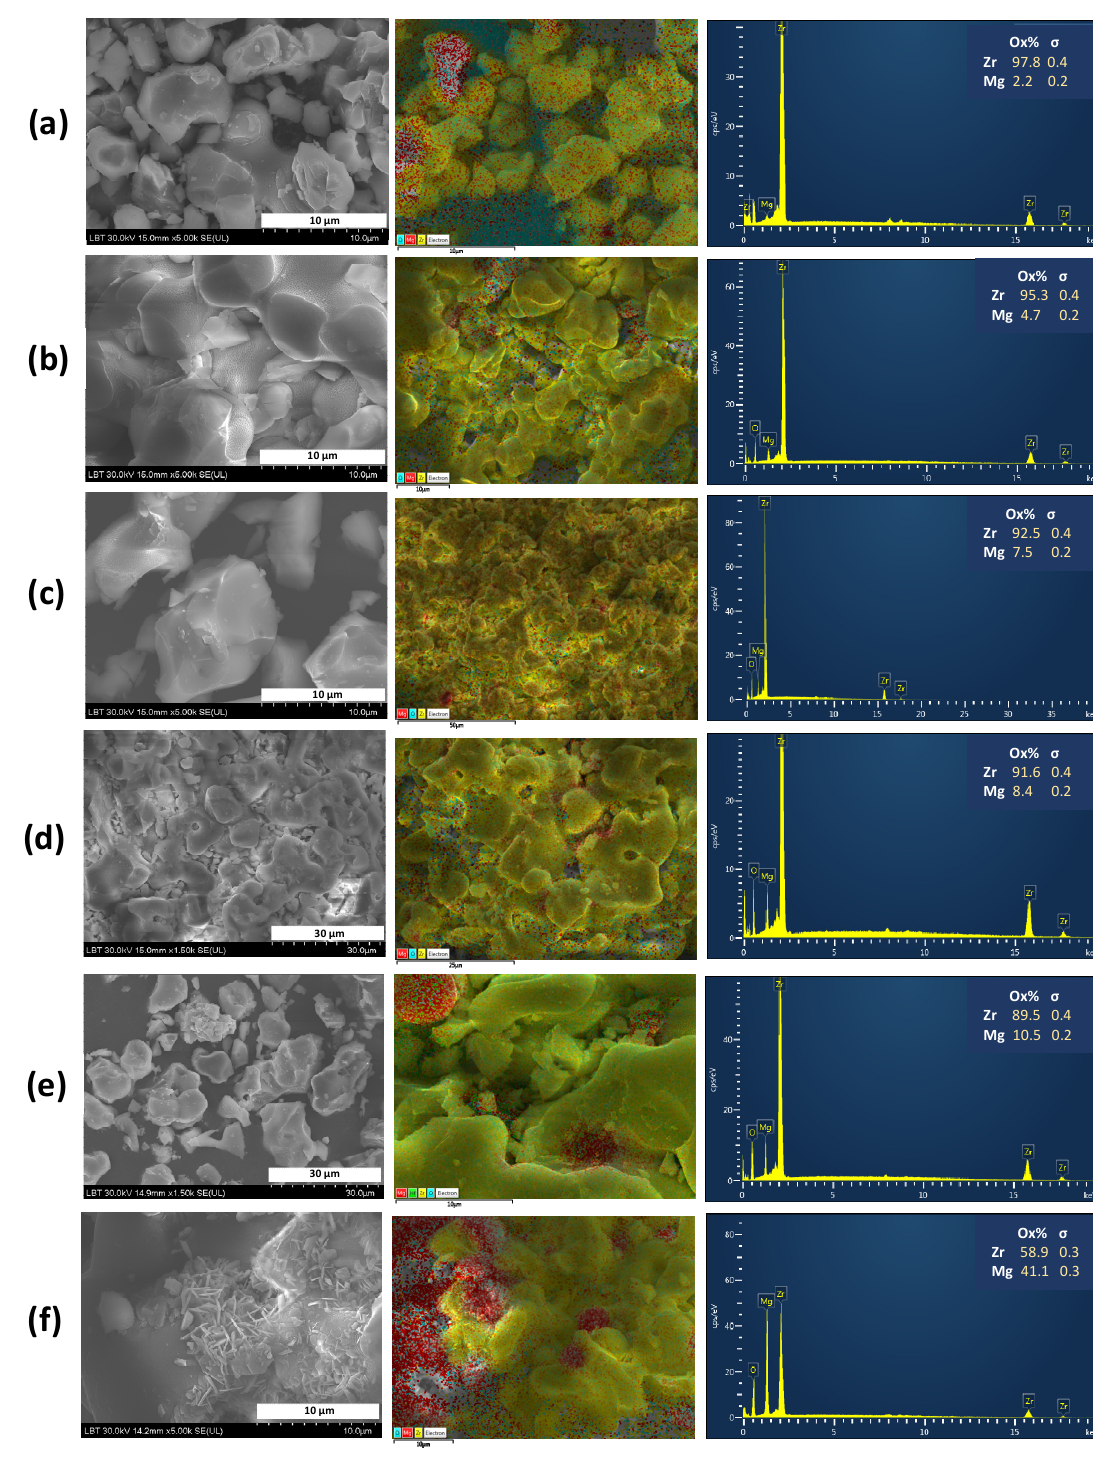
Figure 3. SEM images ( left ), elemental mapping ( middle ) and EDS spectra ( right ) of ( a ) x = 0.05, ( b ) x = 0.1, ( c ) x = 0.15, ( d ) x = 0.2, ( e ) x = 0.25 and ( f ) x = 0.3 compositions belonging to the Zr 1 − x Mg x O 2 system, before immersion in Xerostom ® saliva substitute gel. In the elemental mapping images, the assignment of color for each element is the following: yellow for Zr, red for Mg and blue for O, respectively. The SEM images after immersion (Figure 4a–f) show that the strong interconnection of the grains was